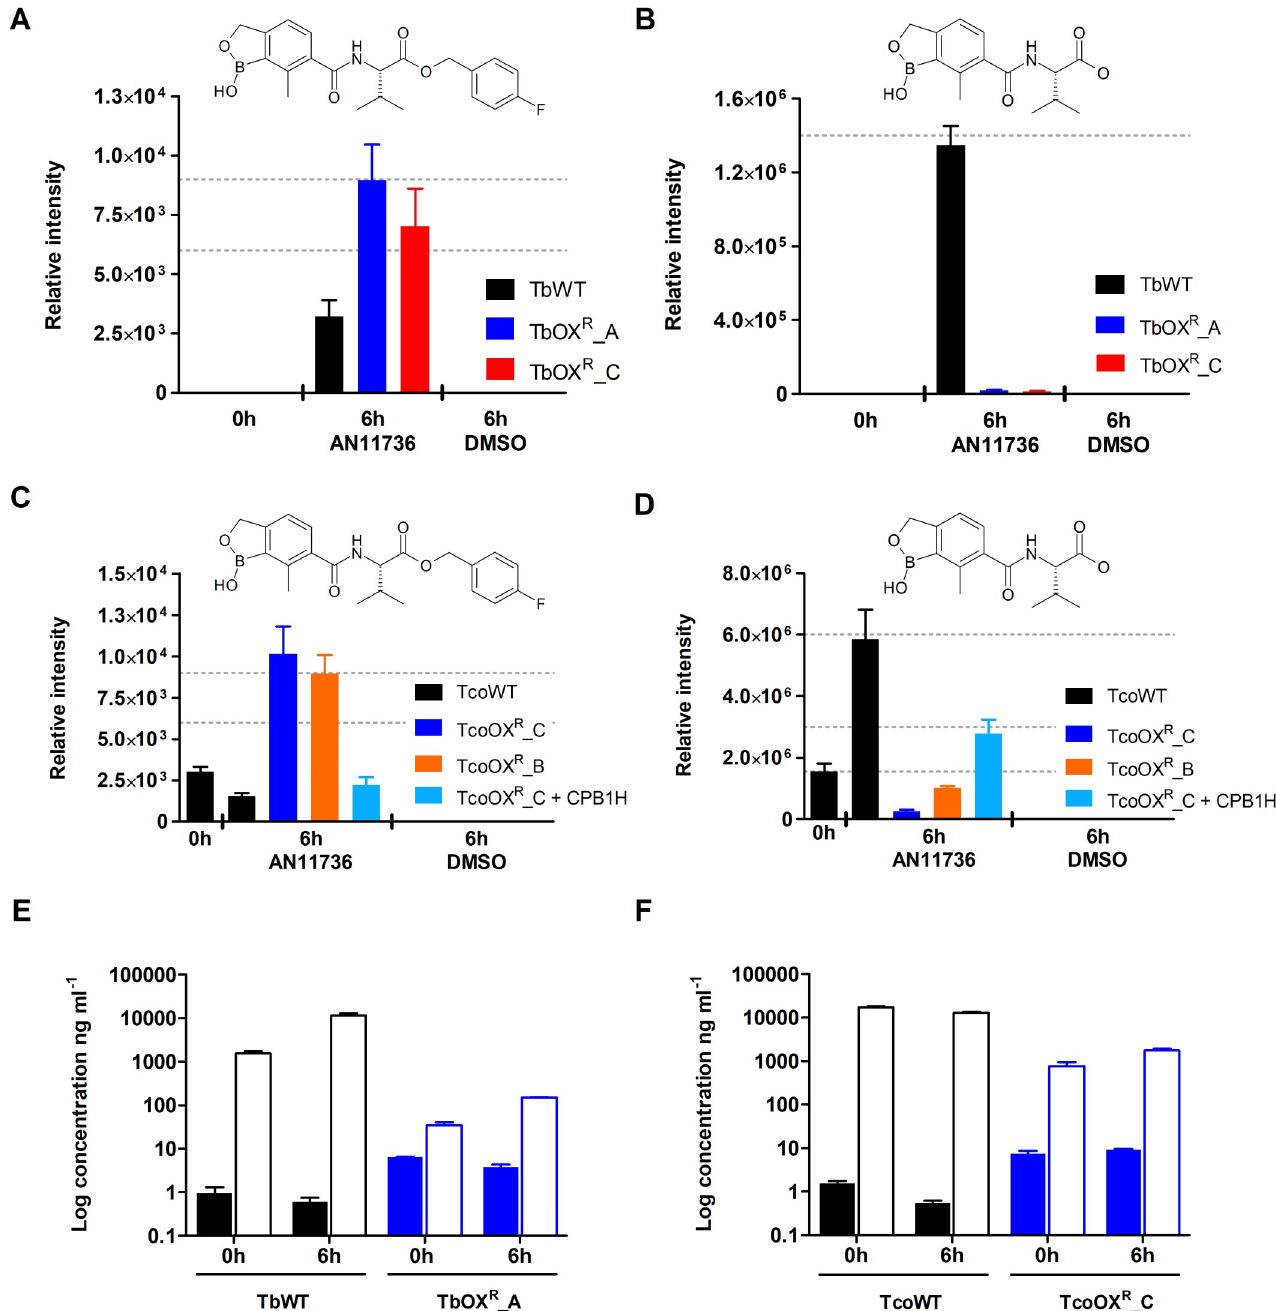
Fig 5. AN11736 is cleaved at the ester bond to a carboxylate derivative, which accumulates at high levels in wild type, but not resistant T . brucei or T . congolense . (A) LC-MS analysis revealed presence of AN11736 in TbWT and resistant lines TbOX R _A and TbOX R _C after 6 h of incubation. (B) A peak of m/z 292.1347 was detected in positive mode in TbWT cells after 6 h of incubation but was barely detectable in resistant cell lines TbOX R _A and TbOX R _C. The peak was identified as the AN11736 carboxylate derivative AN14667, whose chemical structure is shown above the graph. (C) AN11736 was detected in TcoWT, the resistant lines TcoOX R _C, TcoOX R _B and the CBP1H-complemented TcoOX R _C line after 6 h of incubation. (D) The peak of m/z 292.1347 was detected in positive mode in TcoWT cells after 6 h of incubation and at around half the intensity for re-sensitised CBP1H add-back line TcoOX R _C + CPB1H, while the peak was detected at very low levels in resistant cell lines TcoOX R _C and TcoOX R _B, with intensities even lower than that measured for TcoWT at 0 h. (E) Mass spectrometry quantification of AN11736 (full bars) and the metabolite AN14667 (empty bars) in T . brucei wild type (black) and AN11736 resistant line TbOX R _A (blue) over a period of 6 h. (F) as in (E) but for T . congolense wild type and AN11736 resistant line TcoOX R _C. Data represent means ± SD of n = 3 (A-D) or n = 2 (E, F) independent biological